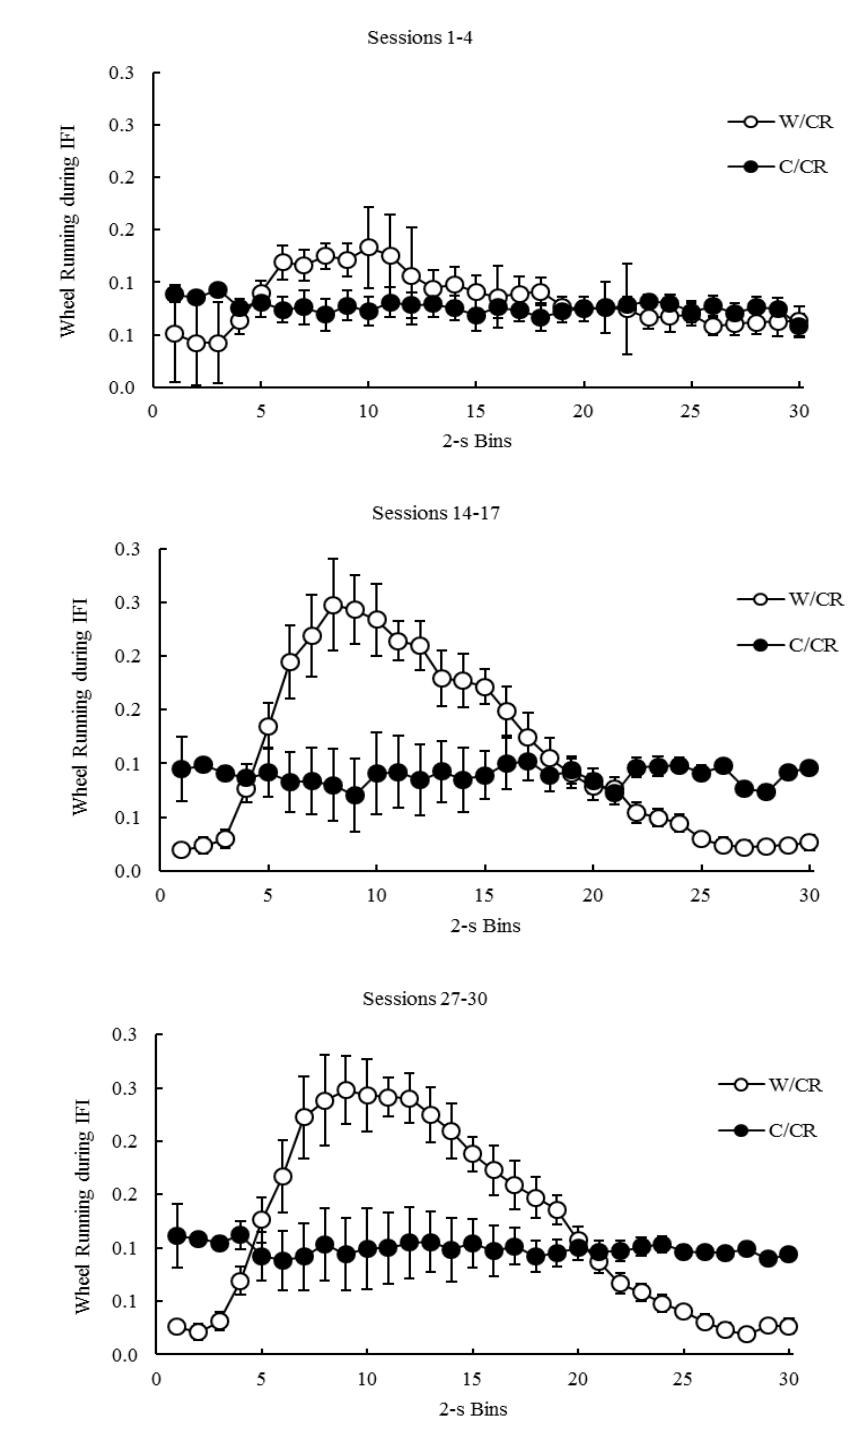
Figure 4. Mean (±SEMs) distribution of wheel running (in meters) within inter-reinforcement intervals plotted in 2-s bins for the initial, intermediate, and final sessions of exposure to the FT 60 s food delivery schedule, for the experimental (W/CR) and control (C/CR) groups. W: access to a wheel during intermittent reinforcement; C: massed-food control; CR: continuous reinforcement. Error bars were always included, but they are difficult to visualize in some